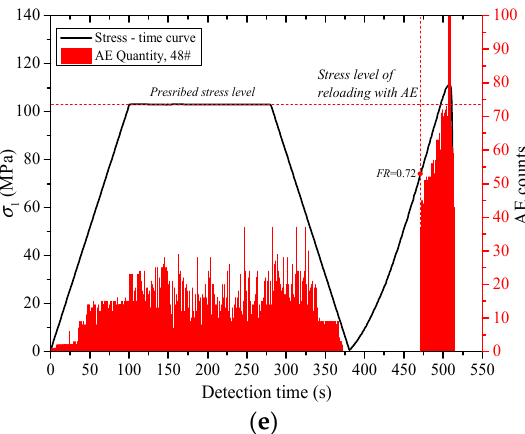
Figure 5. Stress–time–AE curves in uniaxial cyclic loading and unloading test of marble under different stress levels. ( a ) σ A = 0.5 σ c ; ( b ) σ A = 0.6 σ c ; ( c ) σ A = 0.7 σ c ; ( d ) σ A = 0.8 σ c ; ( e ) σ A = 0.9 σ c .